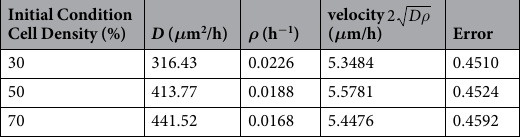
Table 3. Values of estimated parameters for Mouse 1 using initial condition cell densities for Hypothesis 1. Minimization is performed with respect to equation (4).